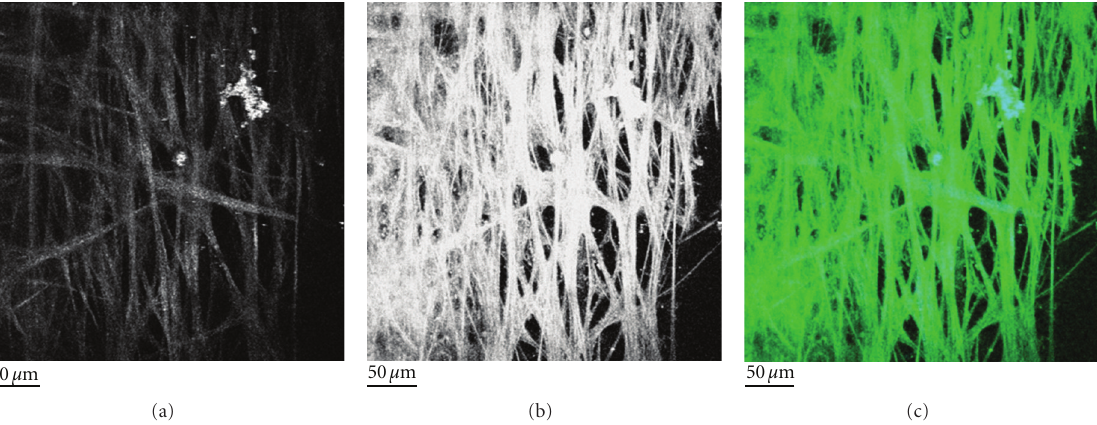
Figure 7: Second harmonic generation (SHG) and two-photon autofluorescence (2PAF) of TM region of a human eye from a 73-year-old donor. A section of the eye was flat-mounted with the anterior chamber facing the microscope objective. Images represent a projection of the multiple z -sections flattened into a single plane. (a) The SHG emission (388nm to 409nm) collected from 800nm excitation of TM. (b) The 2PAF emission window (452nm to 644nm) collected simultaneously. (c) Merged image of SHG (blue) and AF (green) emission. Black scale bar = 50 μ m. This figure is reprinted from